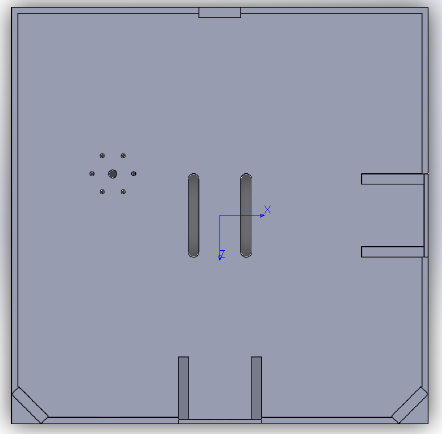
Figure 5. SOLIDWORKS CAD base model, top